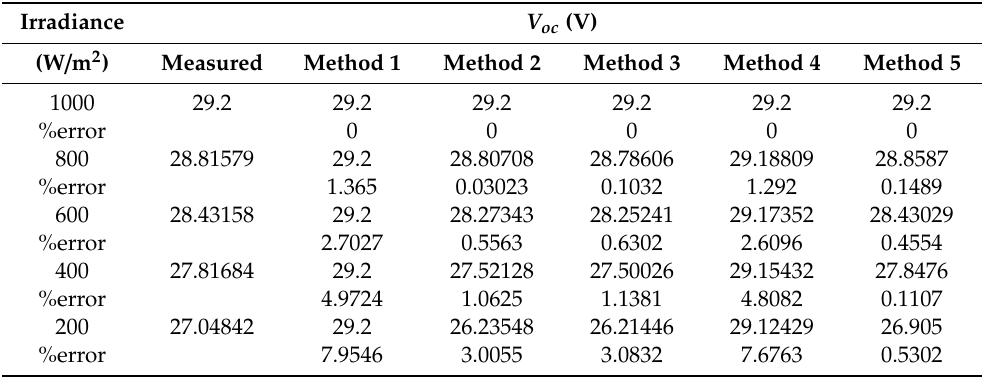
Table 7. Calculated and measured V oc (V) and relative error of the KC175GT module under di ff erent irradiance levels and a temperature of 25 °C.